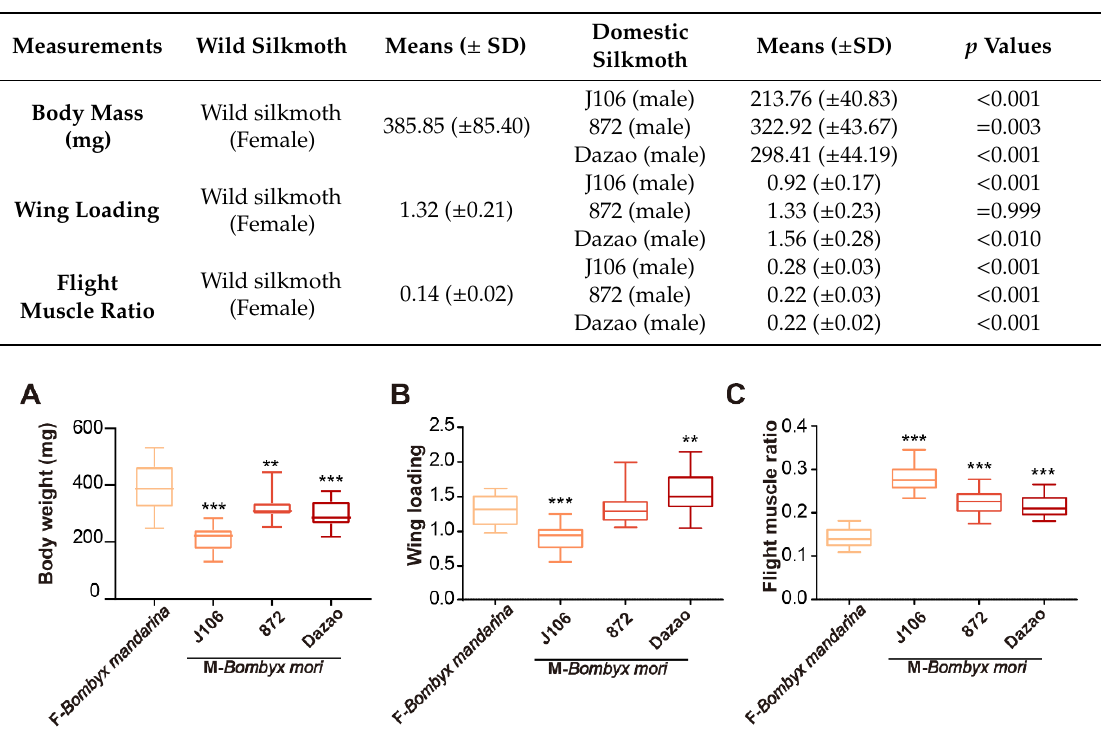
Figure 4. Comparison of body weight (mg), wing loading and flight muscle ratio between female B. mandarina (F-wild silkmoth) and male B. mori (M-domesticated silkmoth). The box-plot and box color were described in the legend of Figure 2. ANOVA tests were conducted between B. mandarina and J106, 872, Dazao, respectively. Tukey HSD post hoc tests are shown in Table 4. The significance level is 0.05 (* p < 0.05, ** p < 0.01, *** p < 0.001). ( A ) Body weight (mg) of B. mori males was significantly lower than B. mandarina females. ( B ) The wing loading of B. mandarina females was significantly larger than that of J106 males and similar to that of 872 males. The wing loading of Dazao was significantly larger than that of B. mandarina females. ( C ) The flight muscle ratio of B. mori males was significantly larger than that of the B. mandarina females. Table 4. One-way ANOVA test of wild females and domesticated males. The mean (±SD) values were the same as shown in Table 1. The table shows Tukey’s comparison between B. mandarina females and each of the three B. mori males, respectively. The significance level is 0.05 (Tukey HSD post hoc tests).